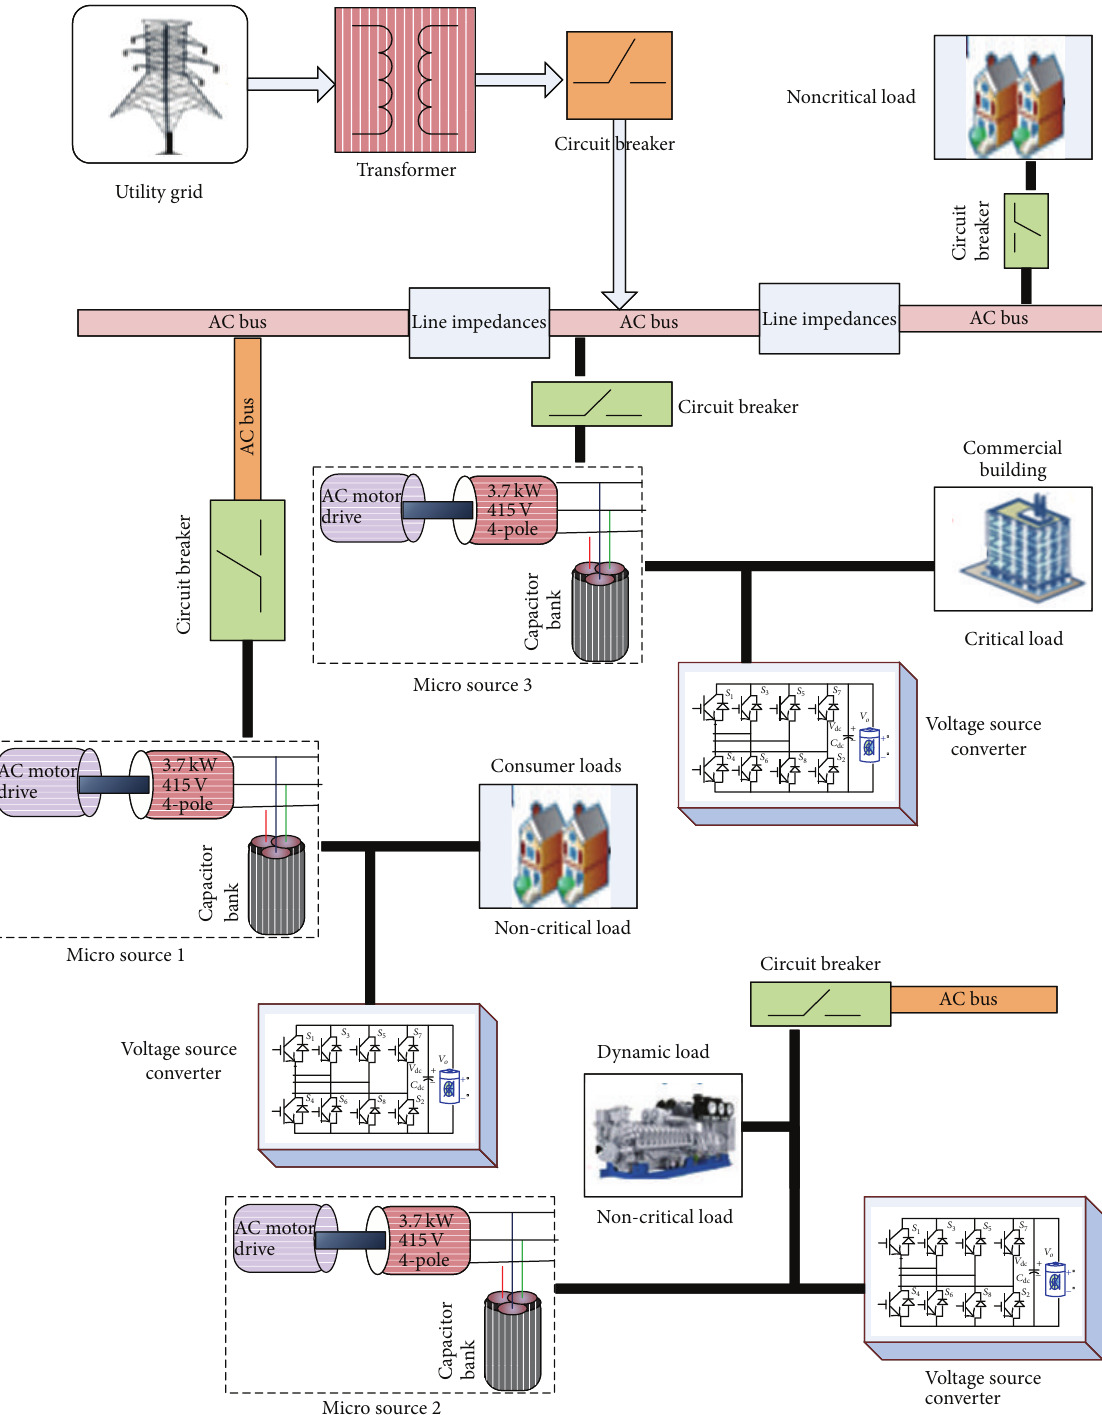
Figure 1: Microgrid